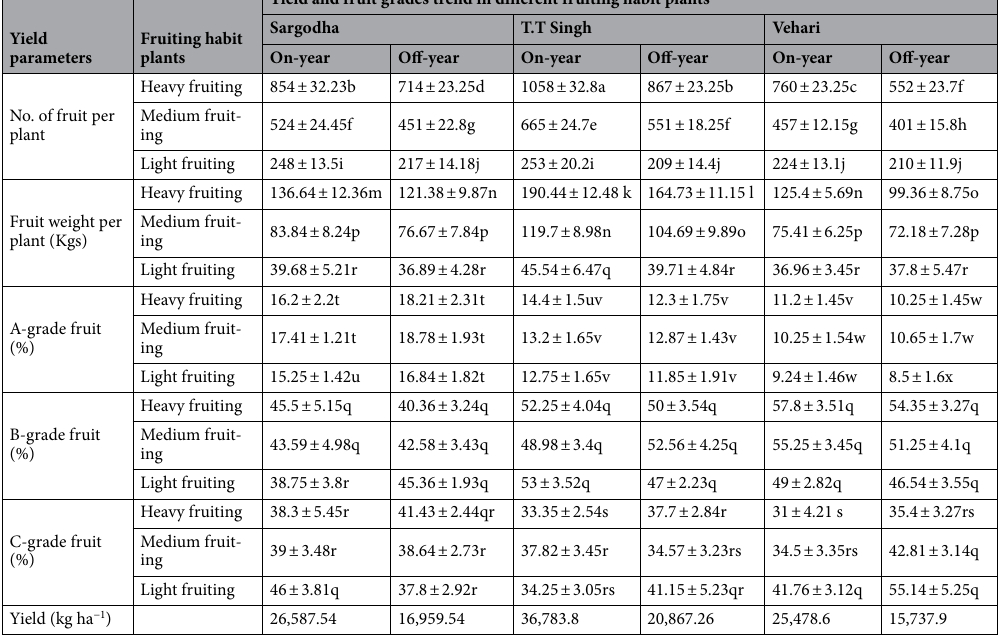
Table 8. Yield and fruit grades quality trend at experimental sites during on- & off-years. Results are shown in means (± SD) and sharing different letters are significantly differed to each other according to LSD test (P ≤